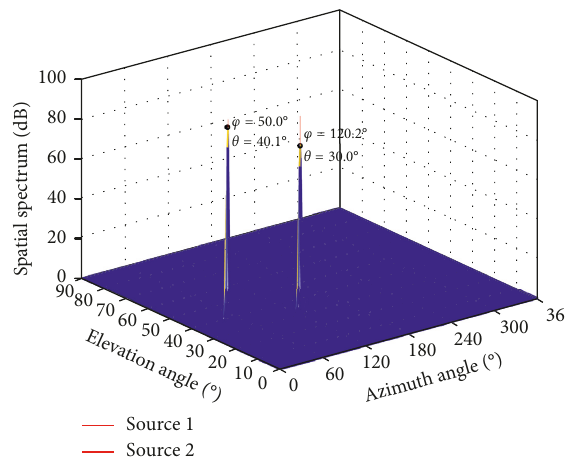
Figure 2: Spatial spectrum by employing the proposed SR method (SNR �